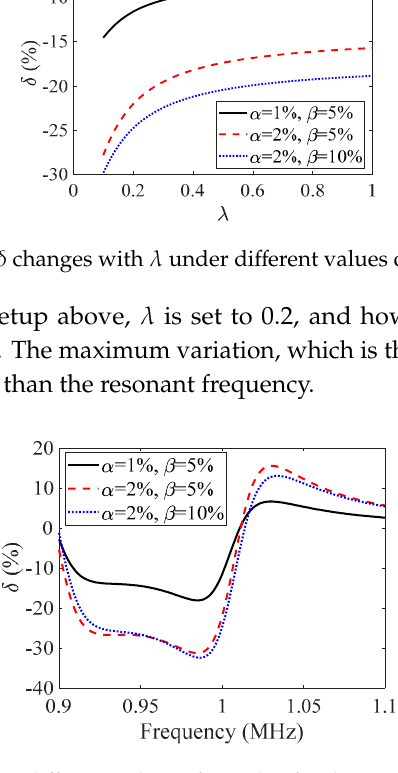
Figure 8. δ changes with f under di ff erent values of α and β , for the SP mixed resonance, when λ = 0.2.